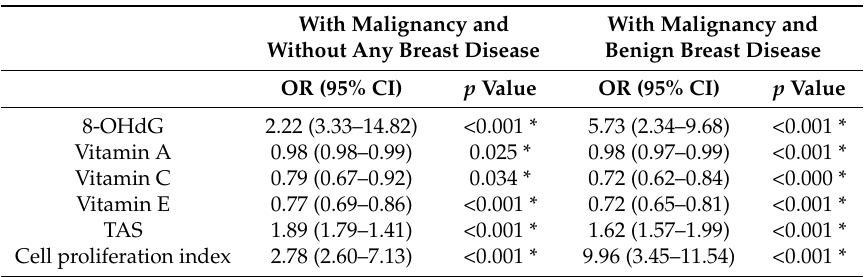
Table 6. Multinomial regression analysis of cell proliferation and oxidative stress markers in relation to breast carcinoma